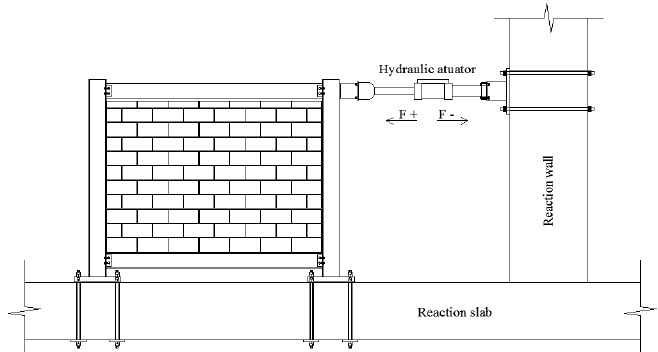
Figure 5. Experimental setup by De Grandi [14]. Source: De Grandi [14]